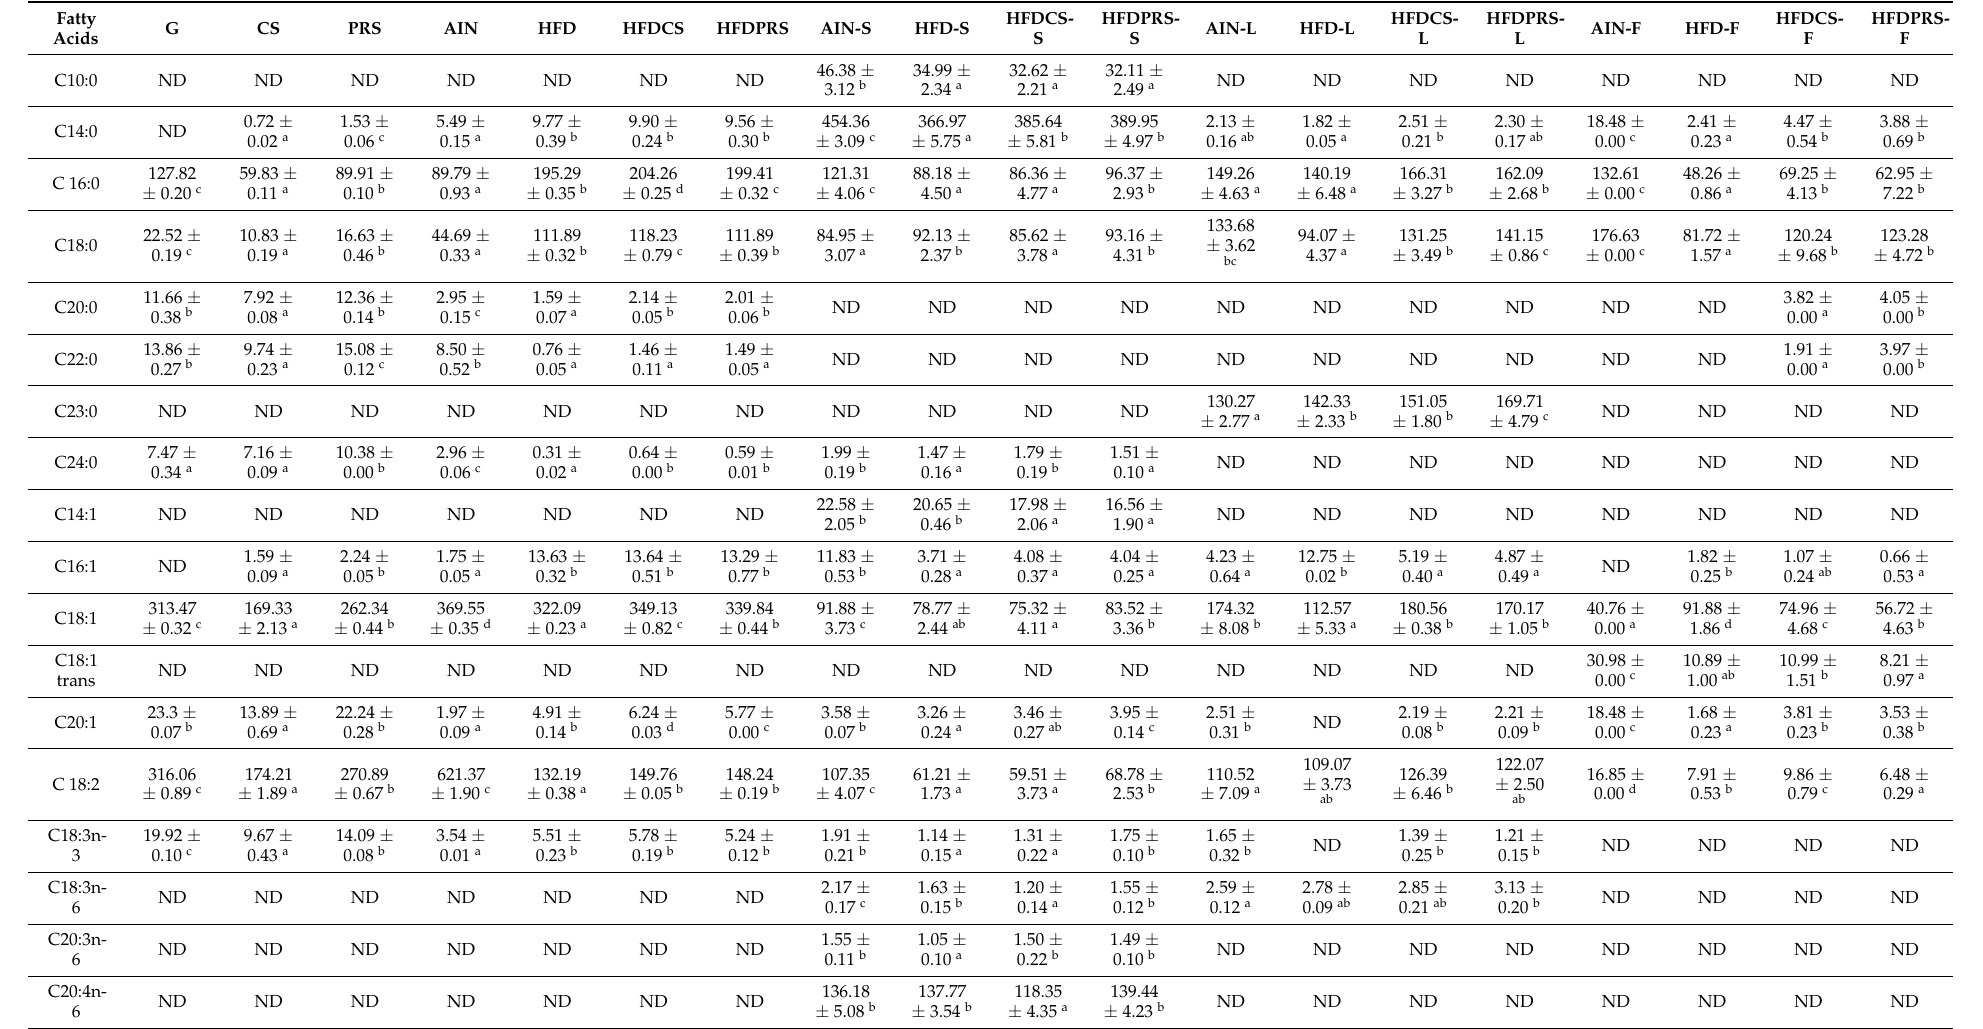
Table 4. The content of fatty acids in buckwheat seeds (mg/g lipids) and sprouts (mg/g lipids), experimental diets (mg/g lipids), serum ( µ g/100 µ L serum), liver (mg/g lipids) and feces (mg/g